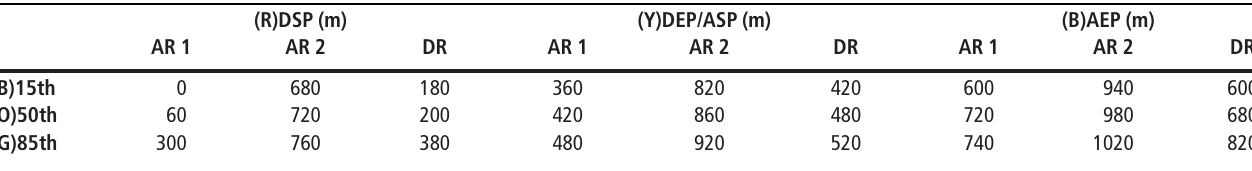
Table 4 Feature points of 15th, 50th, 85th percentile distance